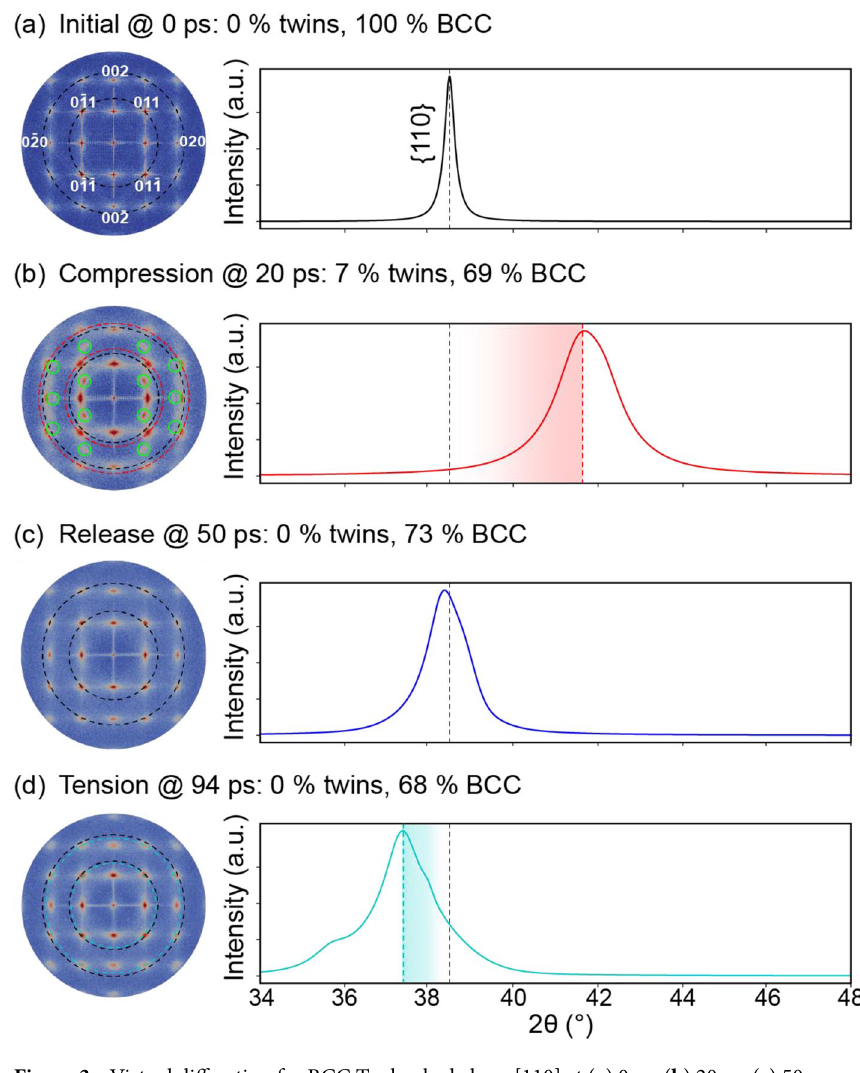
Figure 3. Virtual diffraction for BCC Ta shocked along [110] at ( a ) 0 ps, ( b ) 20 ps, ( c ) 50 ps, and ( d ) 94 ps after impact. Each SAED corresponds to a [100] zone axis, a 1.25-Å −1 radius, and 200-keV electron irradiation. Each XRD represents powder diffraction for Cu-Kα X-rays. For association with diffraction signatures, discrete quantifications of twins and phases are provided in the subfigure labels. For reference, new SAED spots are indicated with solid circles, and the locations of SAED spots and the XRD peak are indicated by dotted lines color-coded by time step. The SAED spots for low-order planes are indexed. SAED patterns are plotted using Paraview 66 , version 5.7 from https:// www. parav iew.